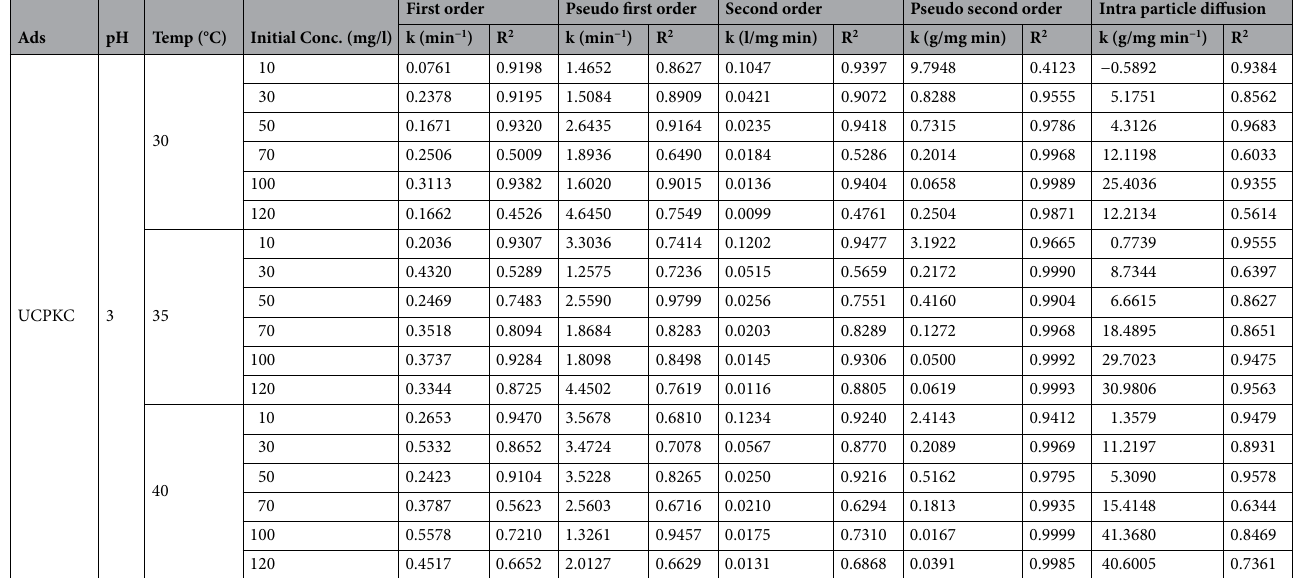
Table 7. R 2 and K values for various kinetic models for UPKC at pH 3 and Temperatures 30 °C, 35 °C and 40